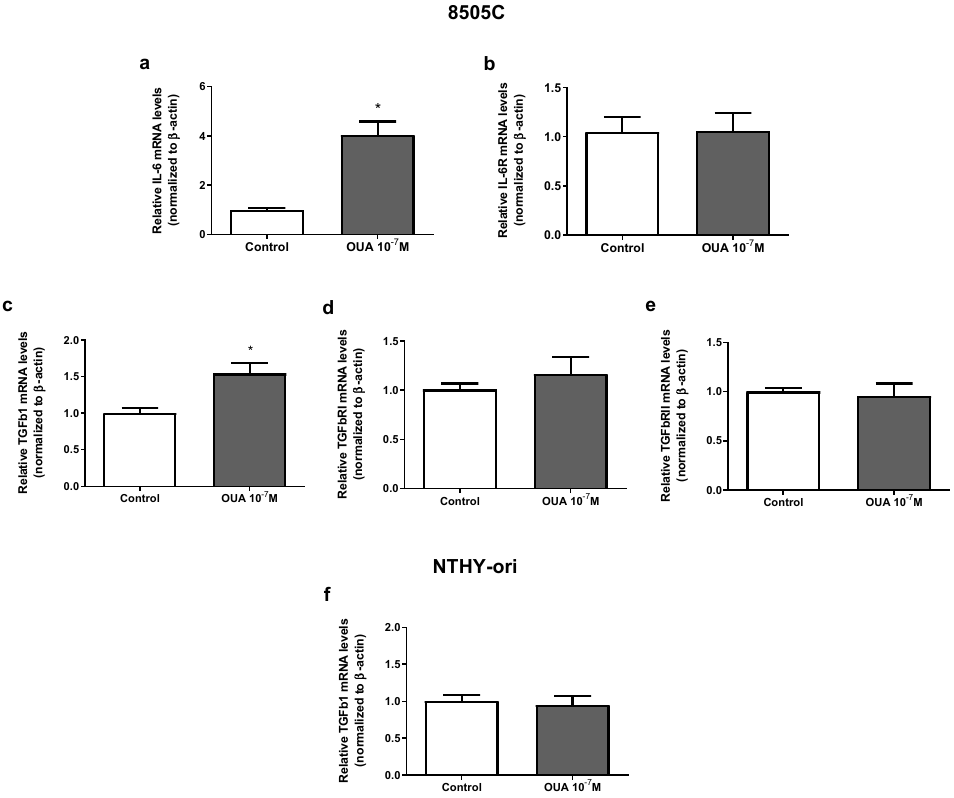
Figure 7. Effect of ouabain on mRNA expression of IL-6, IL-6R, TGF β 1 and TGFRs in 8505C and NTHY-ori cells. Following 24 h of 8505C culture in the absence or presence of ouabain 10 − 7 M, IL-6, TGF β 1 and their respective receptors expression were evaluated using RT-PCR. ( a – e ) Data are presented as the mean ± SEM of mRNA levels of IL-6 ( a ), IL-6R ( b ), TGF β 1 ( c ), TGFRI ( d ) and TGFRII ( e ) in control and ouabain-treated 8505C cells. ( f ) Data are presented as the mean ± SEM of mRNA levels of TGF β 1 in control and ouabain-treated NTHY-ori cells. For this, at least four independent experiments were performed in triplicate. * p < 0.05 using unpaired t-test.